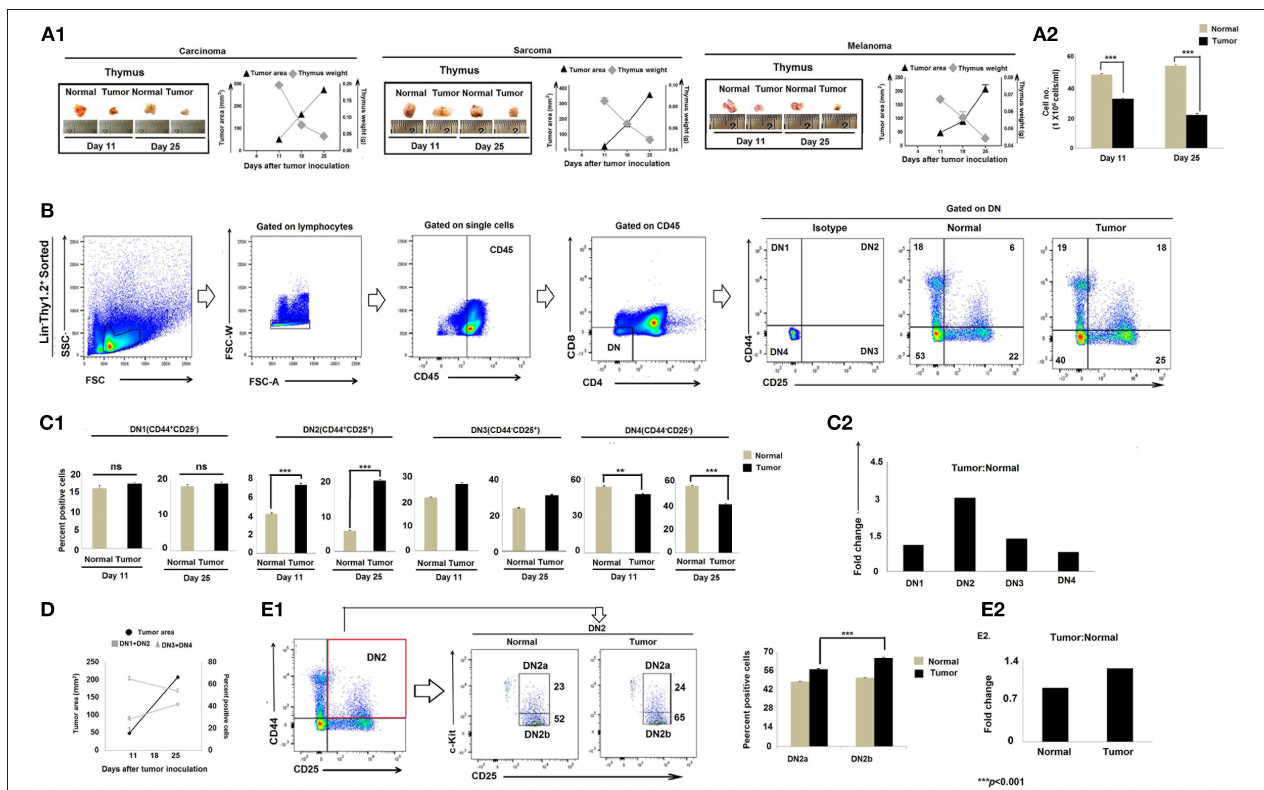
FIGURE 1 | Tumor-induced thymic atrophy is associated with arrest of DN pro-T cell maturation. (A1) Representative figures of thymi normal and tumor (carcinoma, melanoma, and sarcoma)-bearing mice on days 11 and 25 after tumor inoculation, along with line diagrams of tumor area (mm 2 ) vs. thymic weight (gm); n = 12 in each case. (A2) Bar diagram representing total thymocyte number from normal and tumor-bearing mice; n = 12 in each case. (B) Thymic T cells sorted based on Lin − Thy1.2 + phenotype and flow-cytometric analysis of CD25 and CD44 represent DN1 to DN4T cells of normal and tumor-bearing mice. (C1) Bar diagrammatic representations of mean ± SE of positive percentage of Lin − Thy1.2 + DN1 (CD25 − CD44 + ), DN2 (CD25 + CD44 + ), DN3 (CD25 + CD44 − ), and DN4 (CD25 − CD44 − ) T cells, respectively, from normal and tumor-bearing mice; n = 4 in each case, *** p < 0.001. (C2) Bar diagrammatic representation of the fold change of the DN1 to DN4 population of tumor:normal, n = 4. (D) Line diagram of percentage positive T cells (DN1 + DN2 vs. DN3 + DN4) and tumor area (mm 2 ) of tumor-bearing mice on different days after tumor inoculation. (E1) Flow-cytometric representations of Lin − Thy1.2 + -sorted T cells with CD25, CD44, and c-Kit staining, indicating the percentage of DN2a and DN2b cells. Bar diagrammatic representation of positive percentage of DN2a (CD25 + CD44 + c-Kit high ) and DN2b (CD25 + CD44 + c-Kit low ) cells from normal and tumor hosts; mean ± SE; n = 4 in each case, *** p < 0.01. (E2) Bar diagrammatic representation of the fold change of DN2a:DN2b expression from normal and tumor-bearing mice, n =